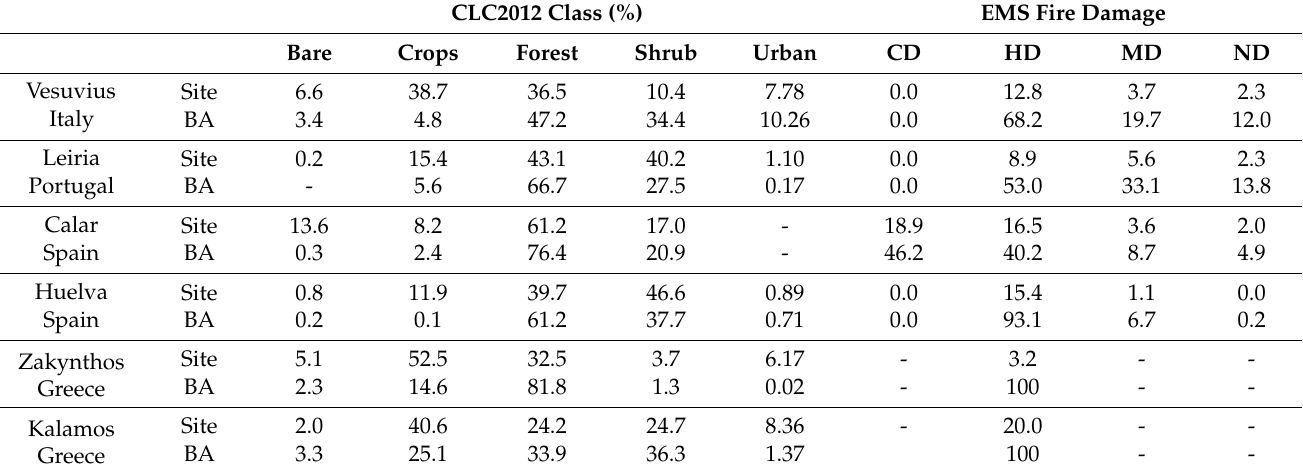
Table 1. CLC2012 land cover classes over the entire site and within fire perimeter identified by EMS. In the last column, the proportions of fire damage levels in the burned area according to EMS fire grading products (CD = Completely Destroyed, HD = Highly Damaged, MD = Moderately Damaged and ND = Negligible to Slightly Damaged), where available.